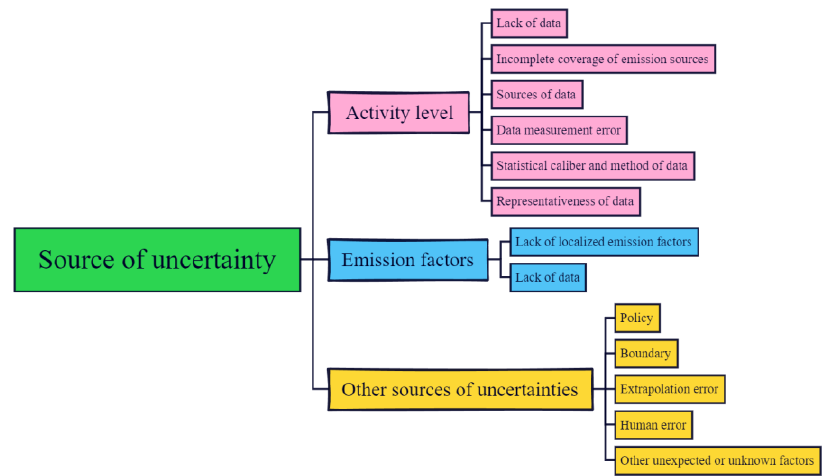
Figure 2. Uncertainty analysis framework of the CO 2 emissions inventory in industrial parks (IPs).